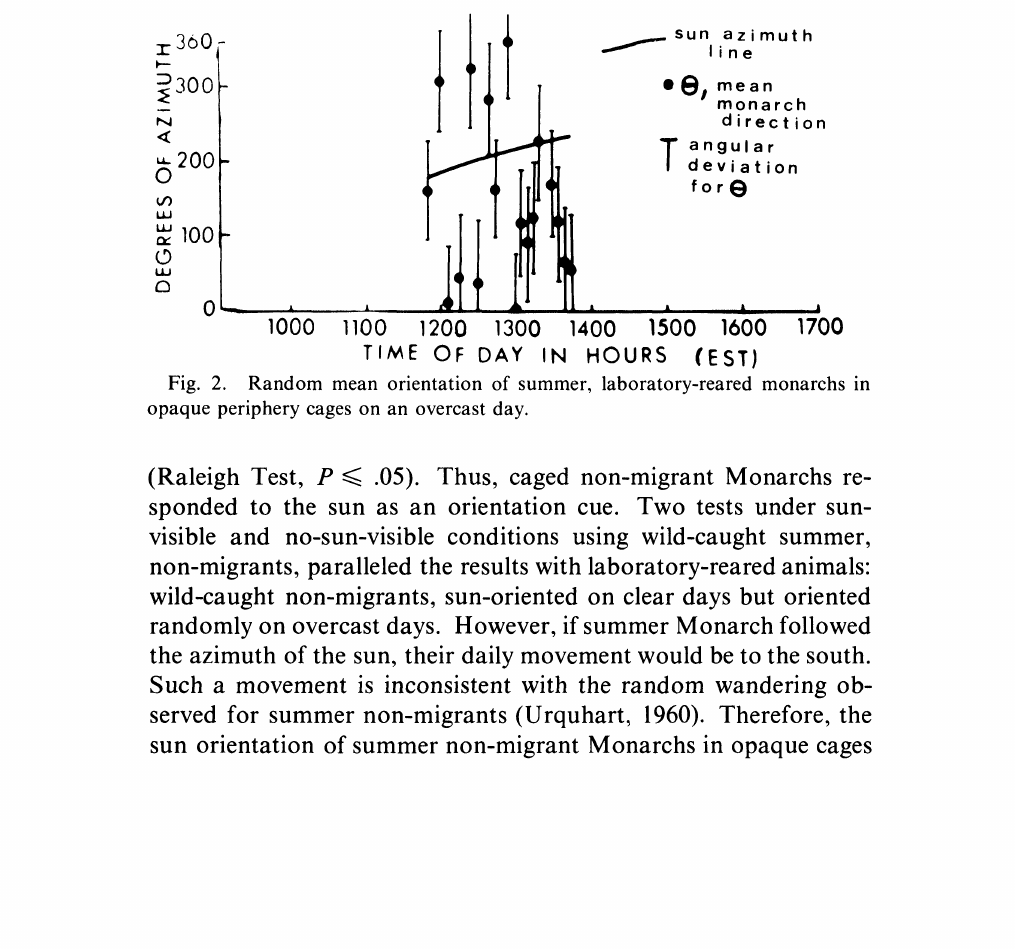
Fig. 1. Orientation of laboratory-reared, summer, non-migrants in an opaque periphery cage on a clear day. O’s lie close to the sun azimuth line throughout the course of the test.